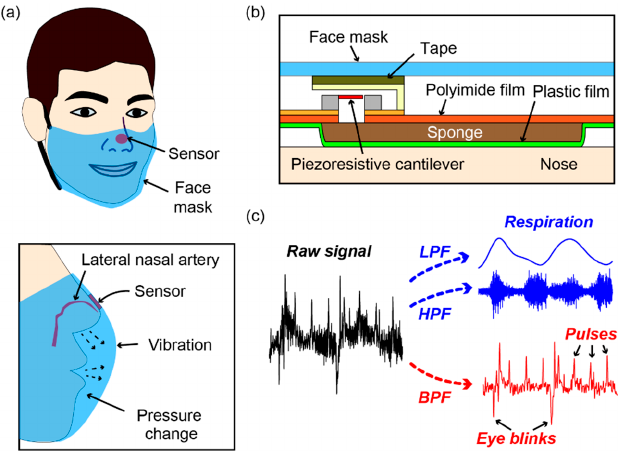
Figure 1. ( a ) Conceptual illustration of the proposed face mask-type sensor. ( b ) Structure of the proposed sensor. ( c ) Sensing principle of the sensor. LPF: low-pass filter, HPF: high-pass filter, BPF: band-pass filter.